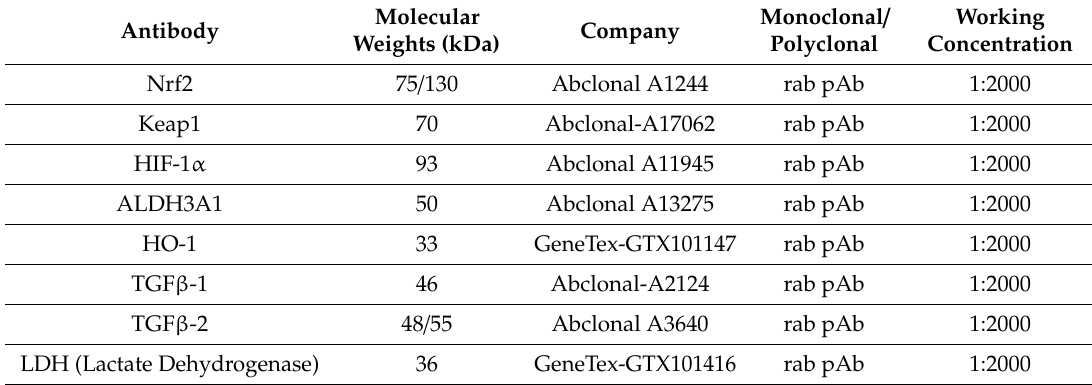
Table 1. Antibodies